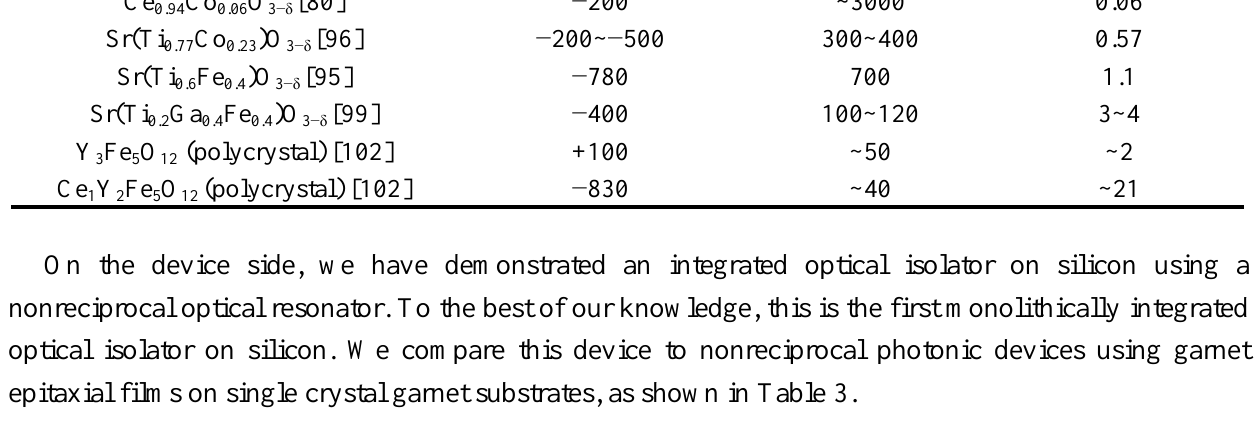
Table 3. Comparison of the resonator based optical isolator on silicon to integrated isolators on garnet using epitaxial thin